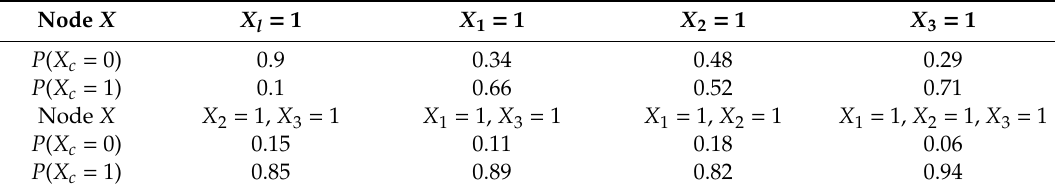
Table 6. Conditional probability parameters of Node “Seepage of dam foundation” ( × 10 − 4 ).